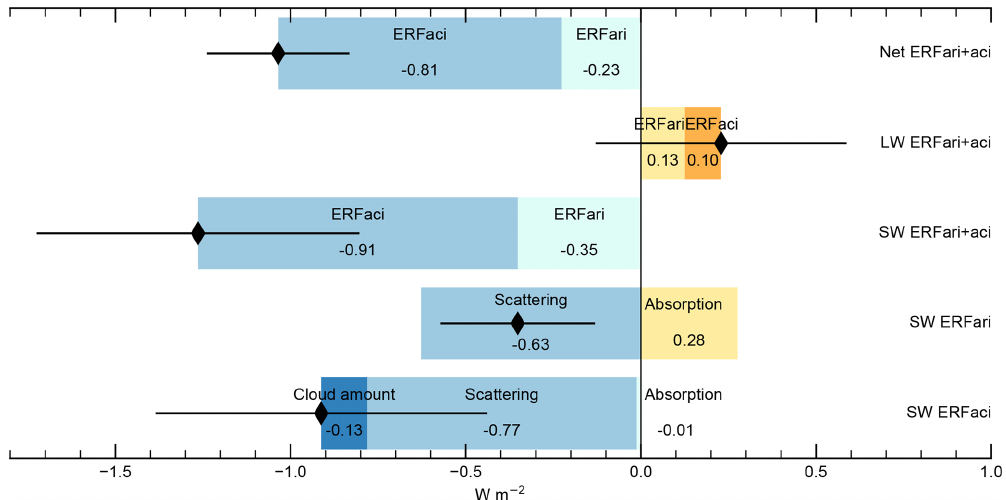
Figure 10. Components of the aerosol forcing diagnosed from the approximate partial radiative perturbation (for SW aerosol components) and from the cloud radiative effect (for LW components). Black diamonds represent multi-model means; black bars show 1 standard devia-